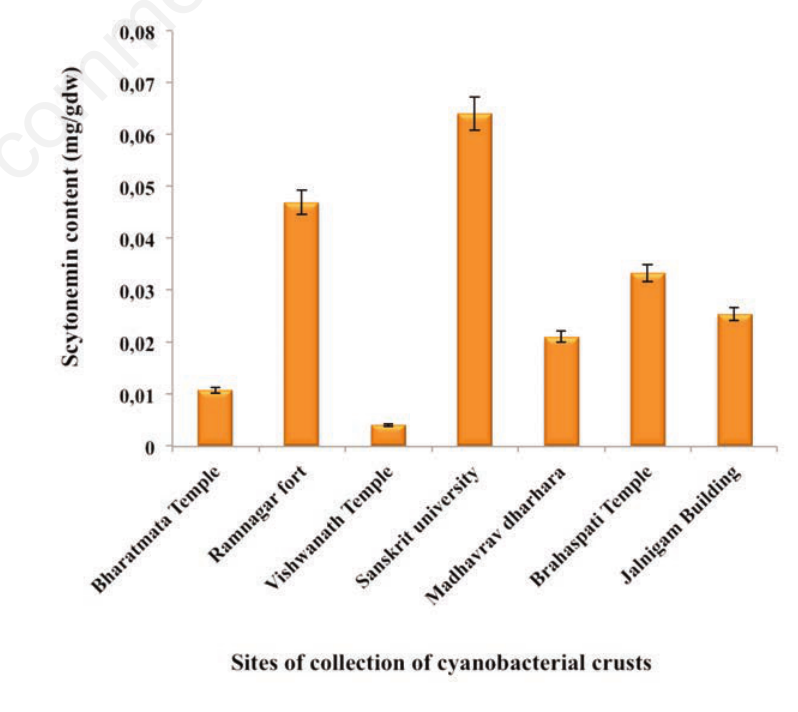
Figure 9. Scytonemin content of cyanobacterial samples collected from different historical monuments of Varanasi. All the experiments were repeated thrice with at least three repli- cates. Bars represent ±